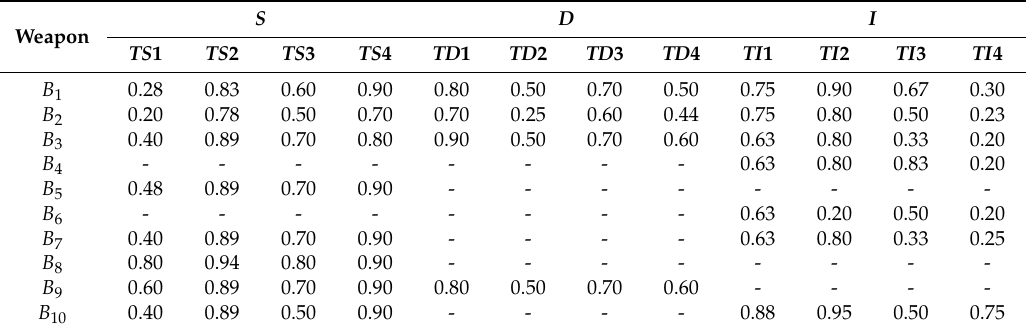
Table 5. Tactical and technical index normalization.